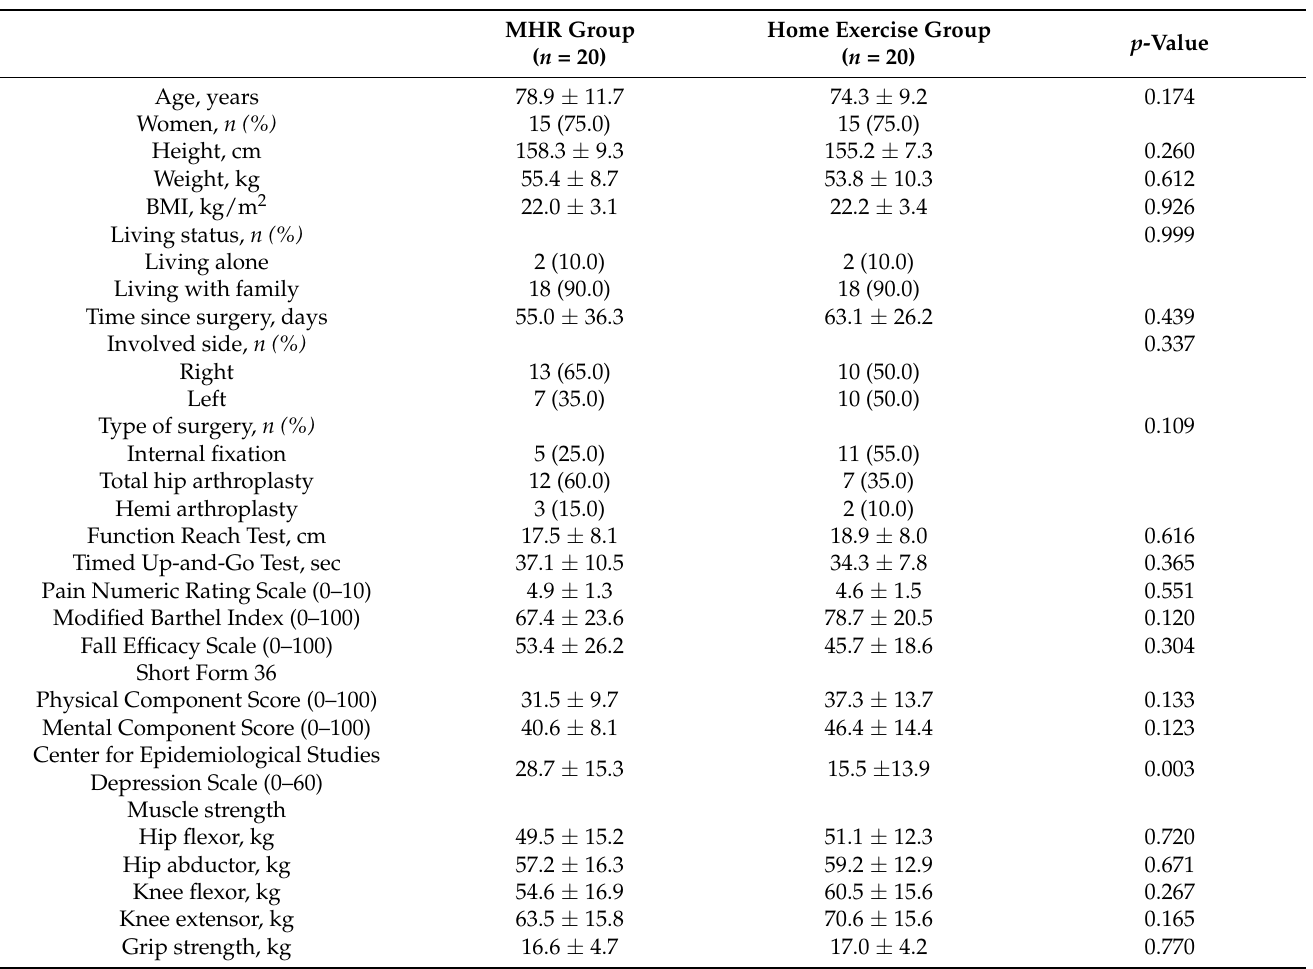
Table 1. Baseline characteristics of the study